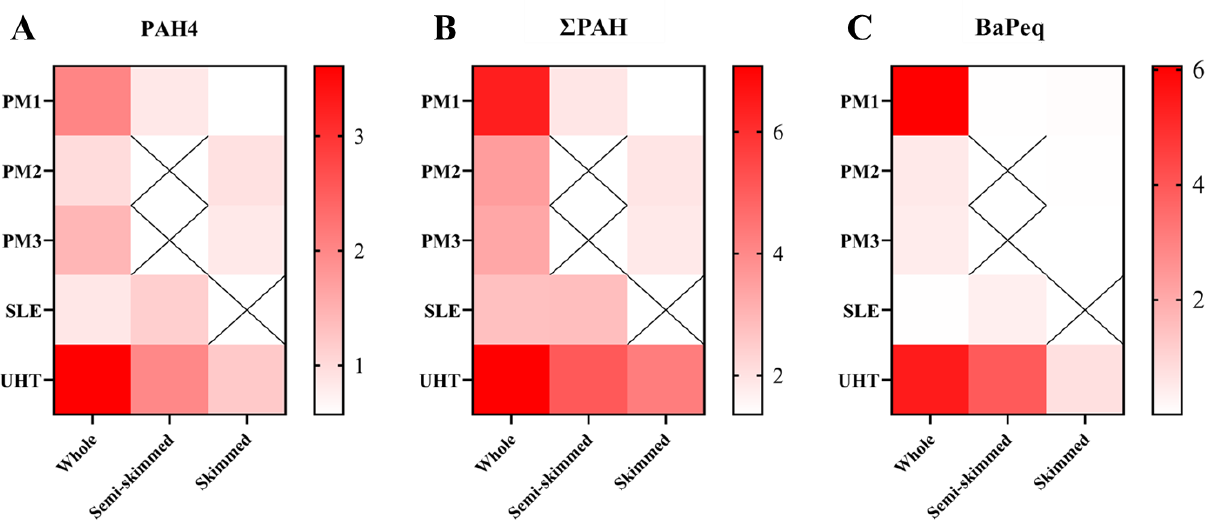
Figure 5. Comparison of PAHs among milk samples with different fat contents. PM: pasteurized milk, ESL: extend-shelf-life pasteurized milks. ( A ) concentration of PAH4 (BaP, BaA, Chr, BbF), ( B ) Concentration of 17 PAHs, ( C ) BaPeq of 17 PAHs.